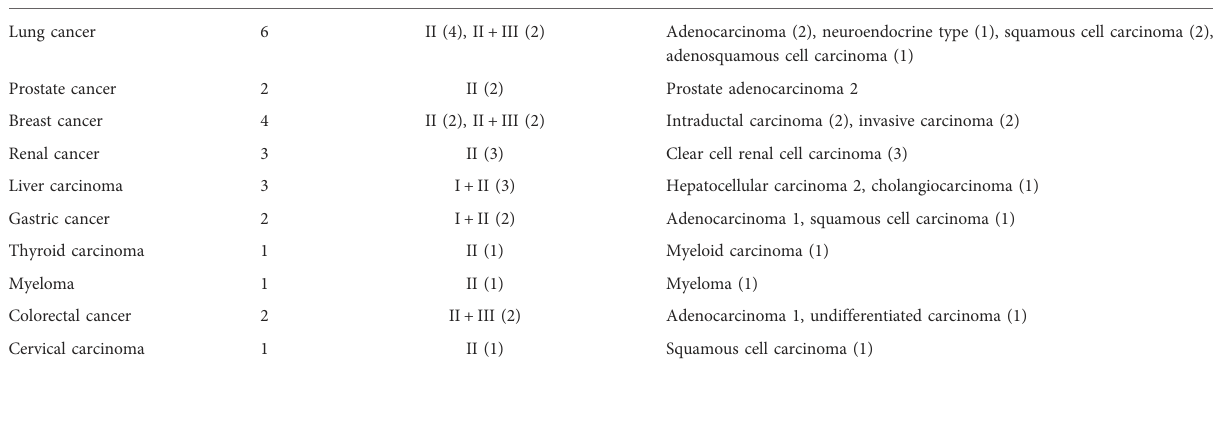
TABLE 1 Clinical characteristic of 25 patients. Primary tumor